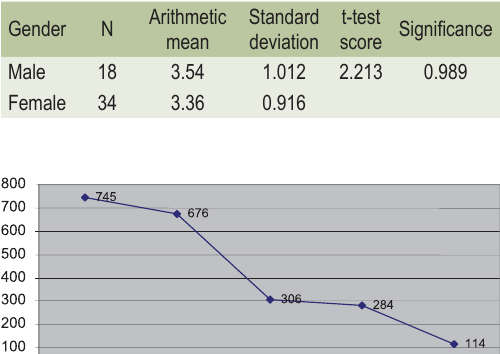
TABLE 1. General opinion about the value of development of managers, as a factor that affects communication in health- care. The data given is for the Clinical center at University of Sarajevo.